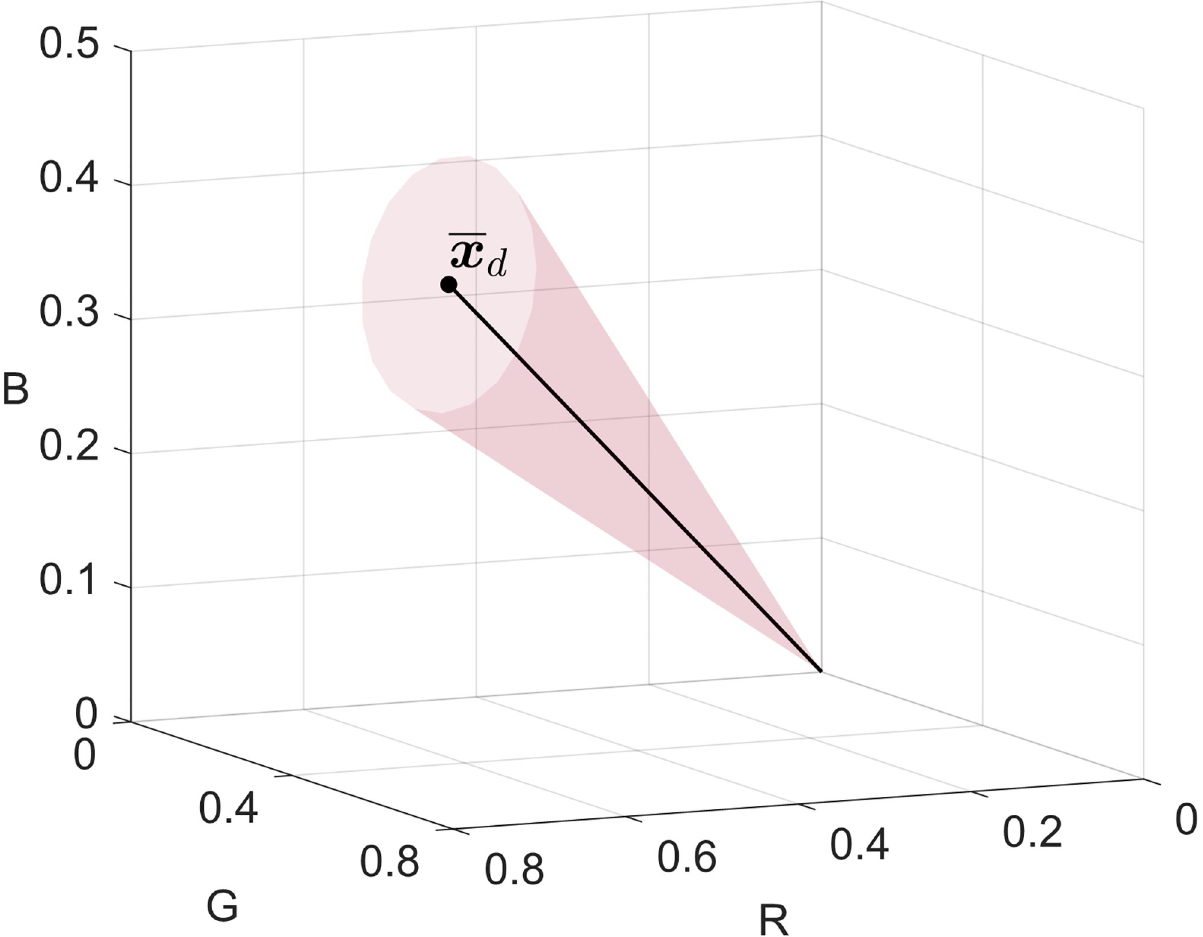
Fig 2. Maximal closed cone containing all accepted vectors in the normalised RGB colour space. The example shows a closed cone defined by the vector � x and a tolerance ξ = d